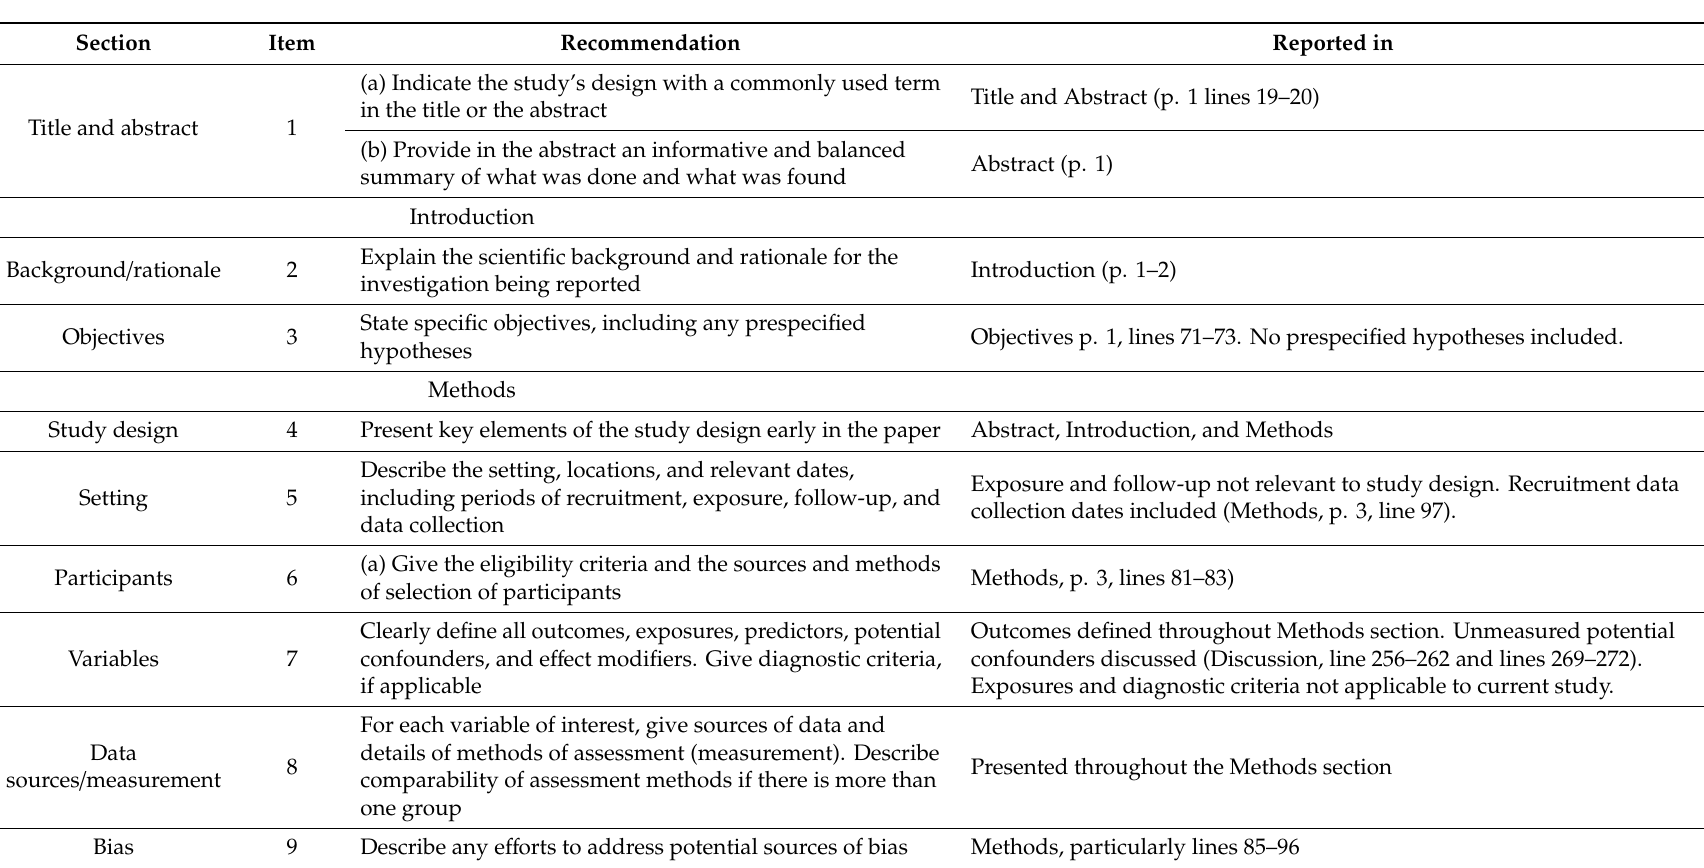
Table A1. Strengthening the reporting of observation studies in epidemiology (STROBE) checklist of recommended items that should be included in reports of cross-sectional